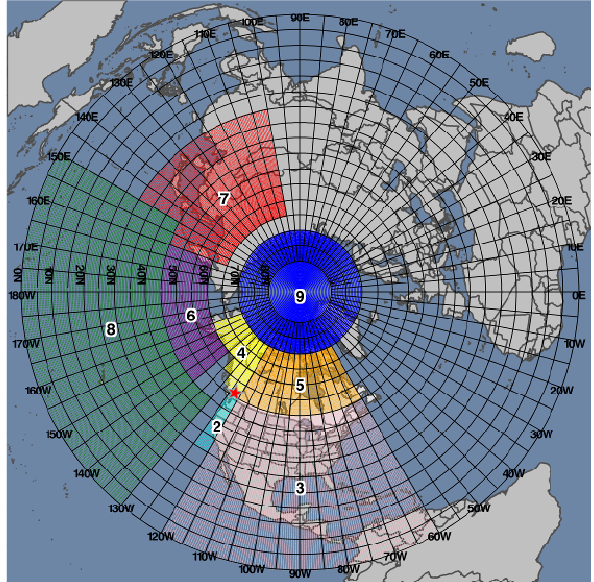
Fig. 5. Locations of boxes defined for trajectory analysis. Boxes 2– 5 represent North American influence; Boxes 6–7 represent Asian sources and trans-Pacific transport; Box 8 is the southern part of the North